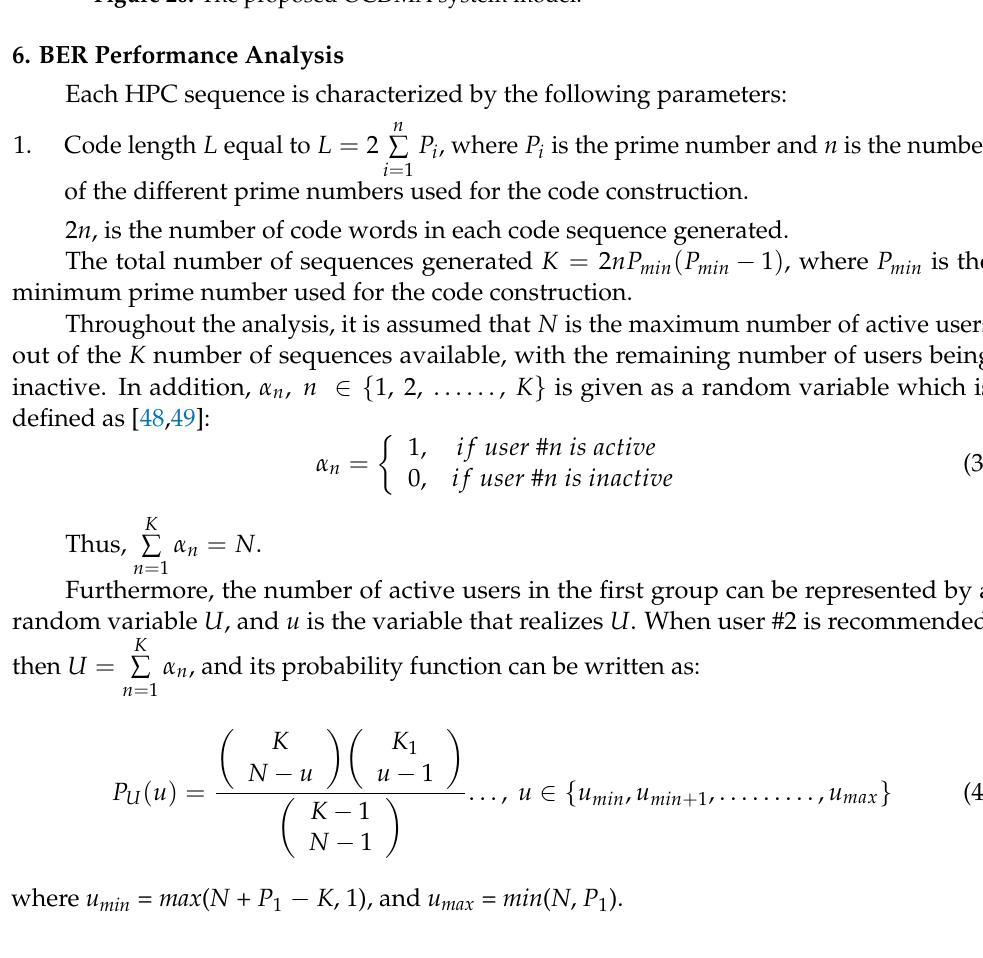
Figure 20. The proposed OCDMA system model.